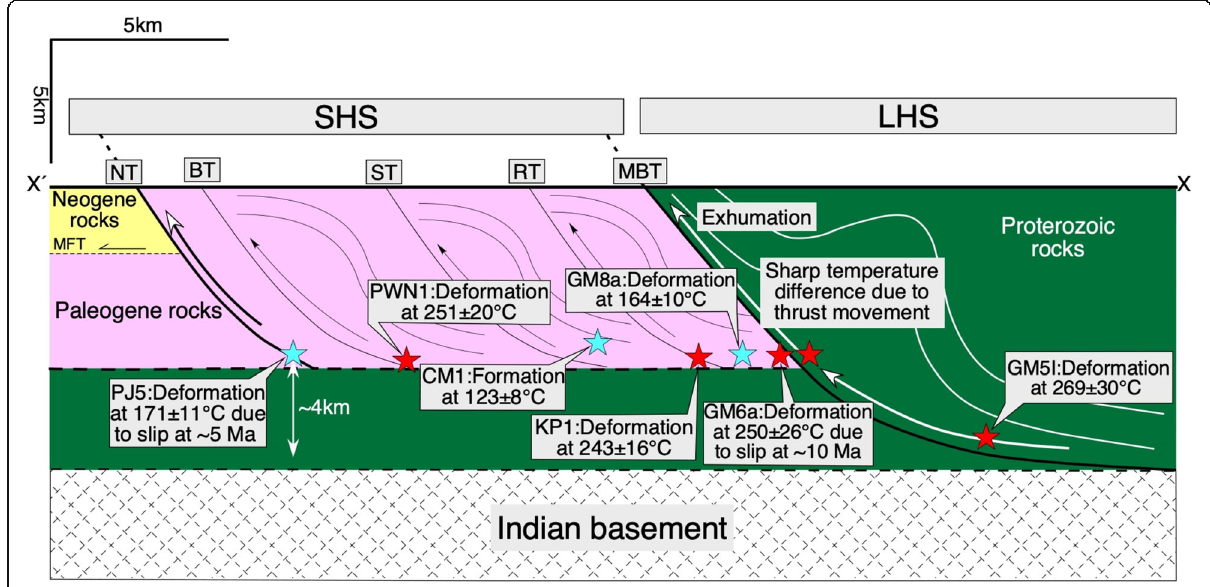
Fig. 7 Sketch showing the schematic structural section along the line X-X ′ (see Fig. 1a for location) with depth vs. temperature data estimated from the deformed calcite samples collected within MBT and NT (Table 3S). Deformation along MBT and NT is due to slip at ~10 Ma and ~5 Ma respectively (Lavé and Avouac 2000). The red star represents the high-temperature deformation while the blue star represents deformation in low temperature. The MBT rocks deformed at depth were exhumed to shallow crustal depths. With evolution of the thrust toward the south, the shallow crustal rocks were deformed at shallower depths, leading to low temperature calcite deformation along the NT. The splay thrusts between MBT and NT show localized increase in deformation temperatures (indicated by the red stars). CM2, GM8 and GM4 are not plotted due to the scale of the